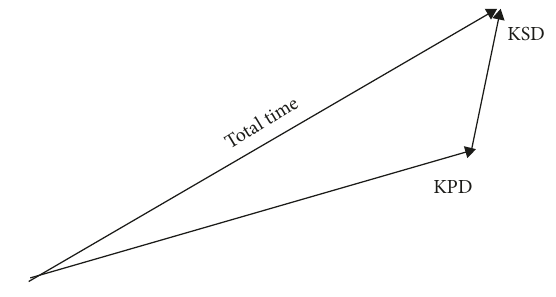
Figure 5: Total time